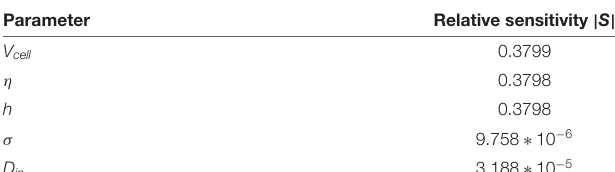
TABLE 5 | Relative sensitivity coefficient for 10% perturbation in each parameter. Parameter Relative sensitivity | S |